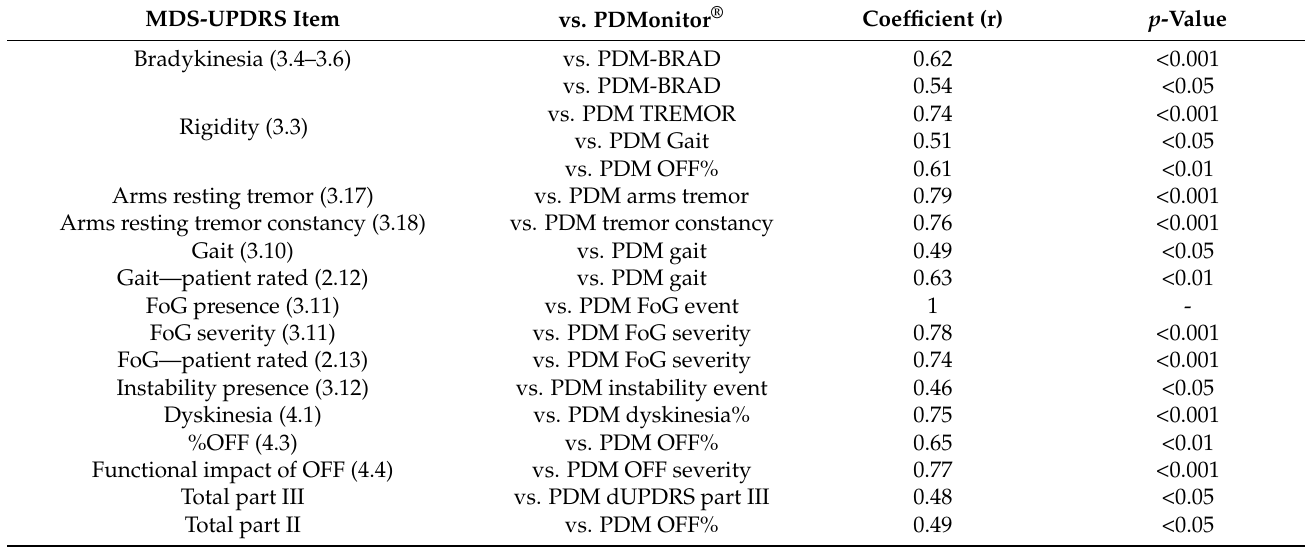
Table 6. Summary of the correlation of the MDS-UPDRS items to the PDMonitor ®